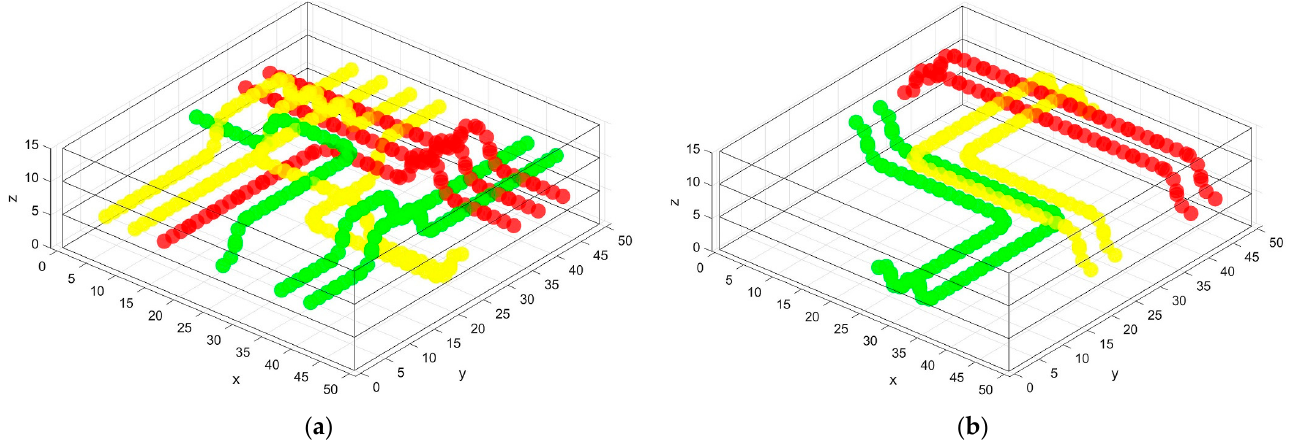
Figure 17. Trajectories of the UAVs scheduled at t i + 1 that will change layer in ( a ) mode 1 and ( b ) mode 2. One UAV is represented by one color and UAVs coming from the same way have the same color.